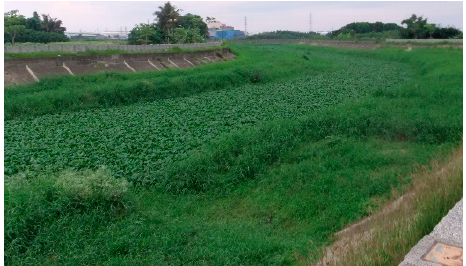
Figure 9. Water hyacinths cover the riverbed at Wulilin Bridge after a long dry period. Three relations were first explored: only SV1 versus WL relation, only SV2 versus SV1 relation,